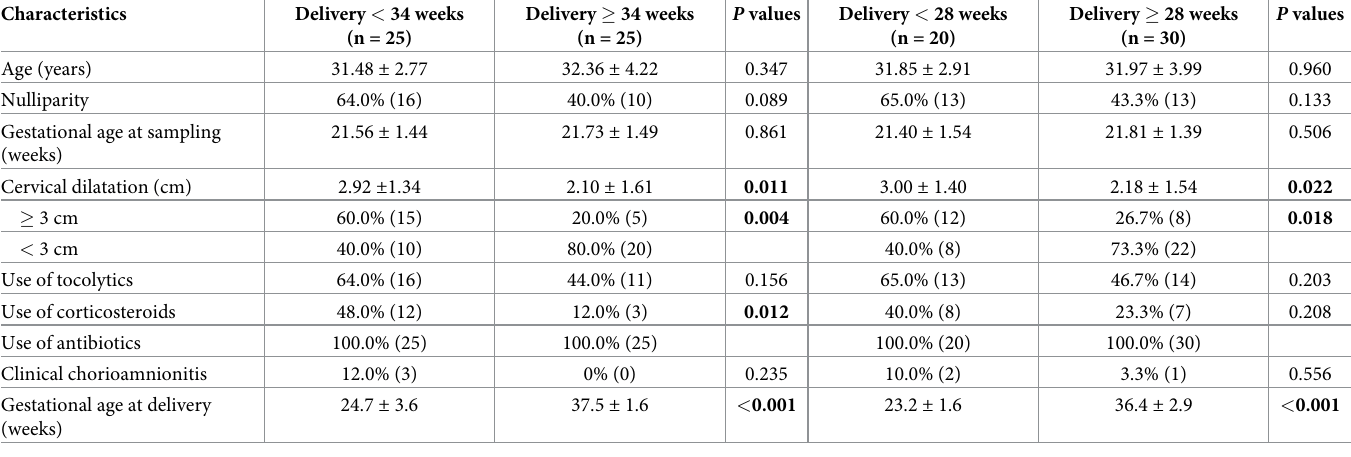
Table 1. Demographic and clinical characteristics of the study